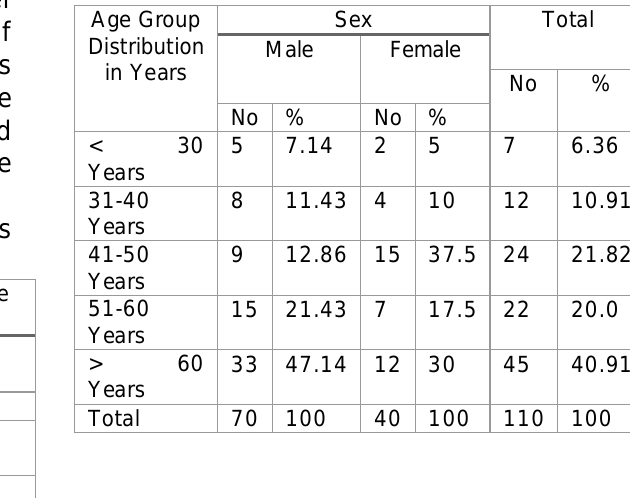
Table No: 4 Age and Sex distribution of